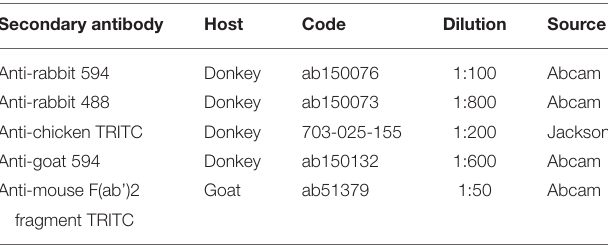
TABLE 3 | Secondary antibodies used in the